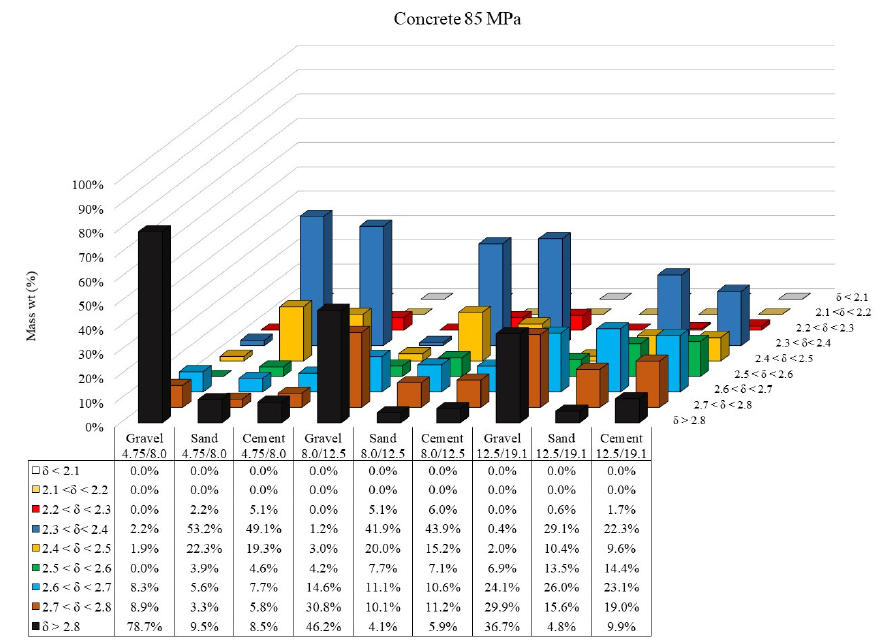
Figure 7. Density distribution of coarse aggregate, sand, and cement paste in three different size ranges (4.75/8.0 mm; 8.0/12.5%; and 12.5/19.1 mm) for Concrete 85 MPa.